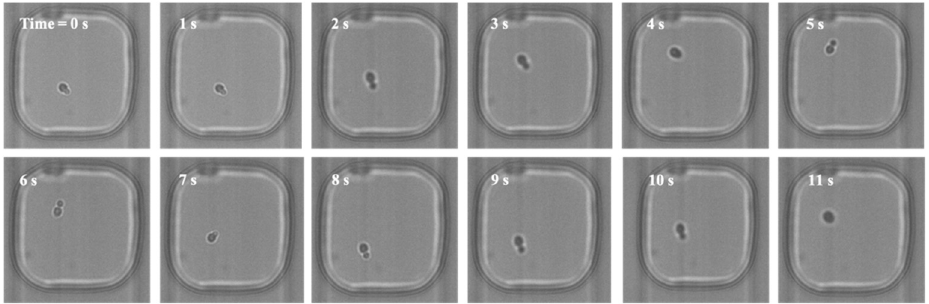
Figure 5 . Progression of the circular movement of the yeast cell in the microwell during the contin- uous fl ow of liquid in the channel at a fl ow rate of 120 µL/min (see also video S2).